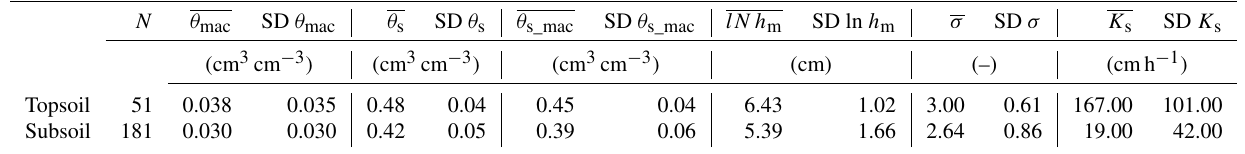
Table 7. Descriptive statistics of the optimized θ mac ( θ s − θ s_mac ),θ s , h m , and σ Kosugi hydraulic parameters. The bar represents the average value, SD is the standard deviation, and N the number of measurement points.